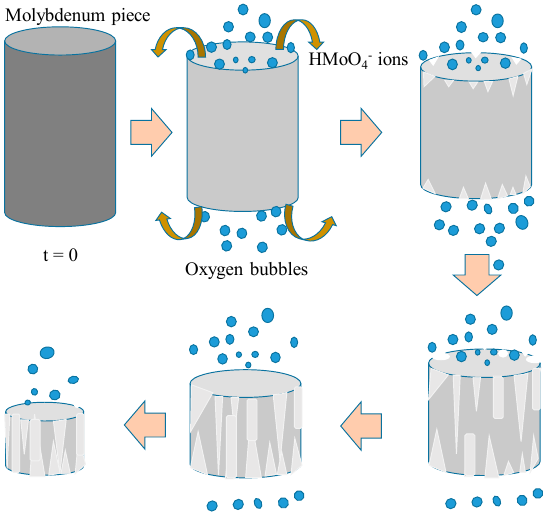
Figure 8. A model representation of the proposed microscopic mechanism.